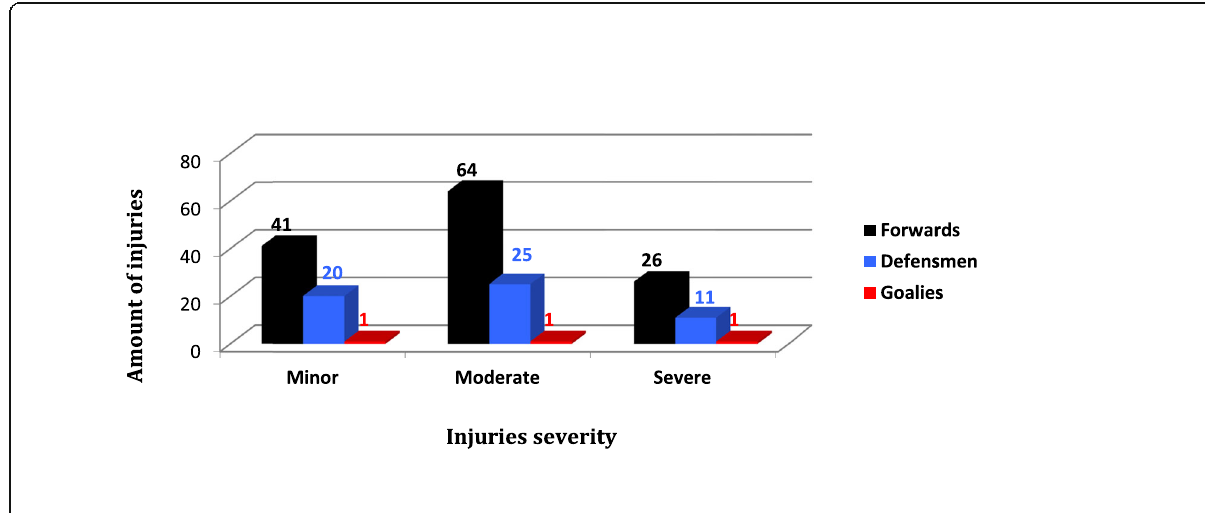
Fig. 8 Injuries (with time loss only) severity distribution by player position